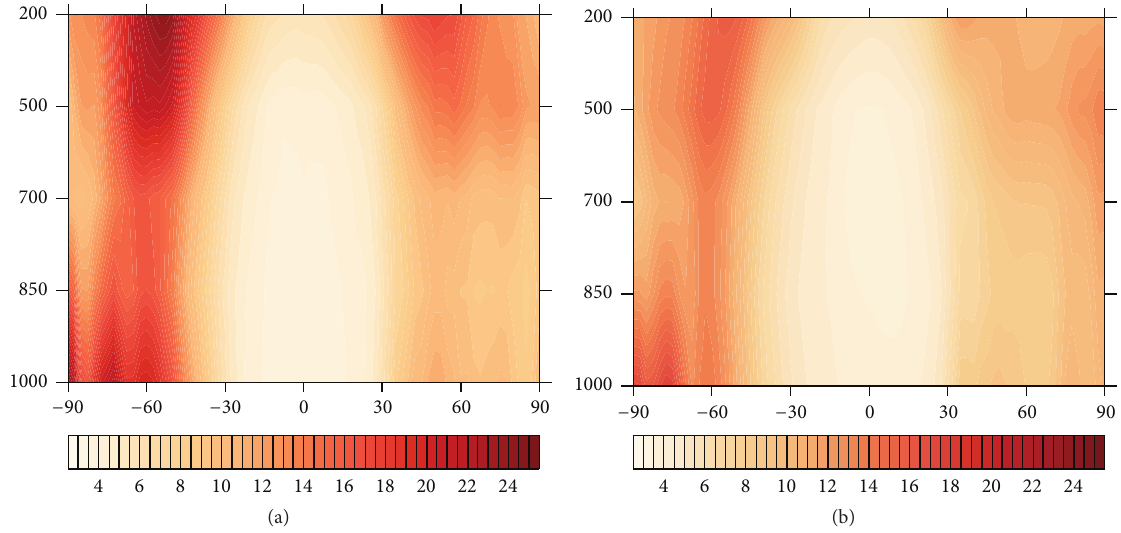
Figure 6: Zonally averaged spread for geopotential (gpm) (a) GSI3DVar and (b)